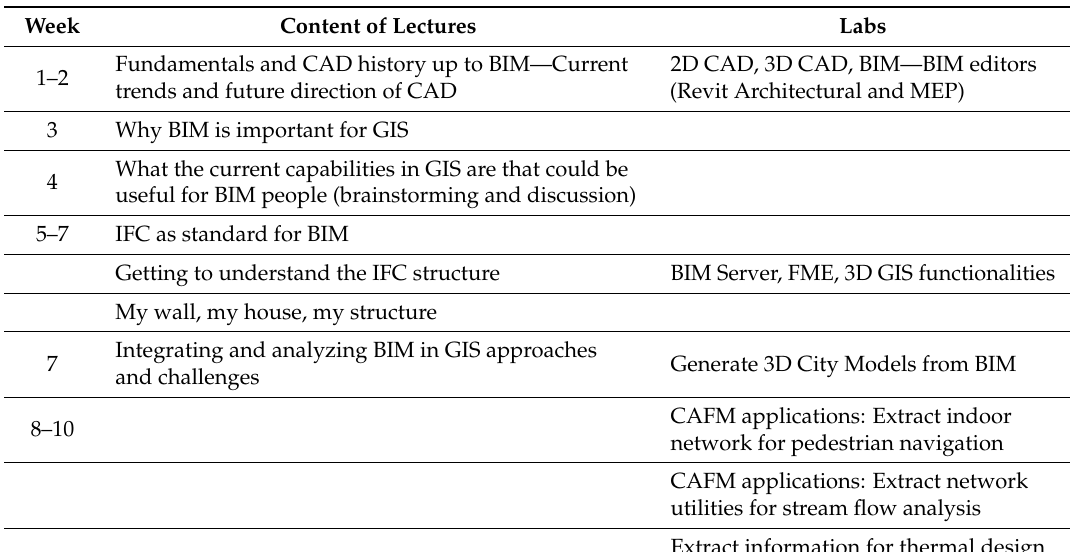
Table 3. Organization of content and